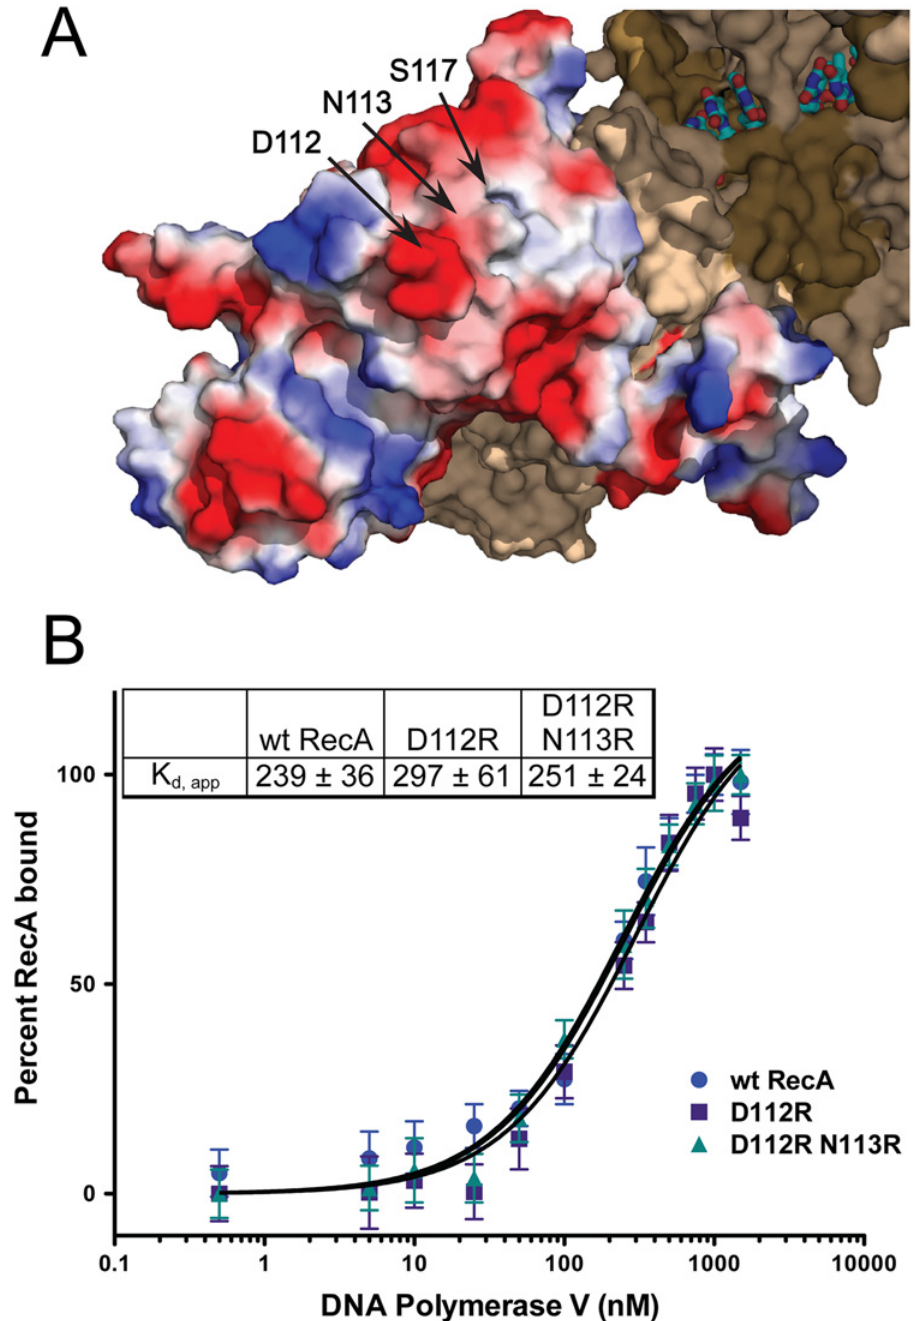
Fig 6. RecA D112R and D112R N113R exhibit wild-type RecA binding affinities for pol V. (A) Location of investigated residues on the RecA protein surface. The D112 and N113 residues compose an acidic knob on the RecA surface. The RecA monomer represented in electrostatic coloring scheme (red = negative charged residues, blue = positive charged residues) was generated in Pymol (PDB 3CMU [67]). In this illustration, the monomer shown is located at the 3' end of the ssDNA (the 3'-proximal RecA monomer), which is the monomer removed by pol V during the activation cycle. (B) Altering this acidic surface to basic residues does not affect the binding affinity for pol V. Equilibrium binding isotherms of wild-type RecA, RecA D112R, and RecA D112R titrated with pol V as monitored by fluorescence depolarization. All data are the average of at least three experiments. Error bars are one standard deviation from the